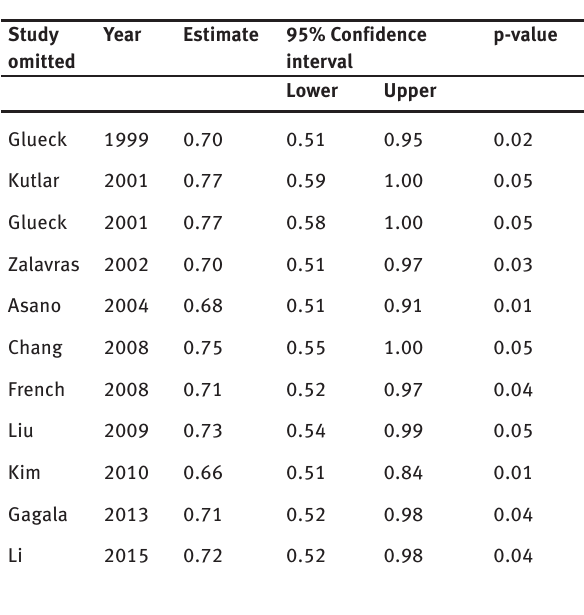
Table 3: The sensitivity analysis of MTHFR C677T polymorphism and non-traumatic osteonecrosis of the femoral head(CC vs